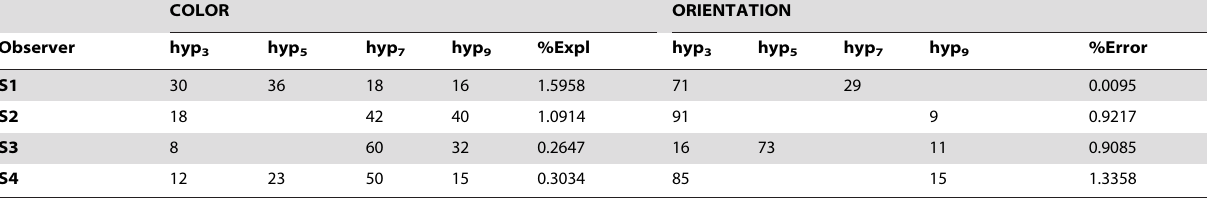
B. The combinations of theoretical hypergeometric models providing the best fit to the empirical psychometric functions ( N